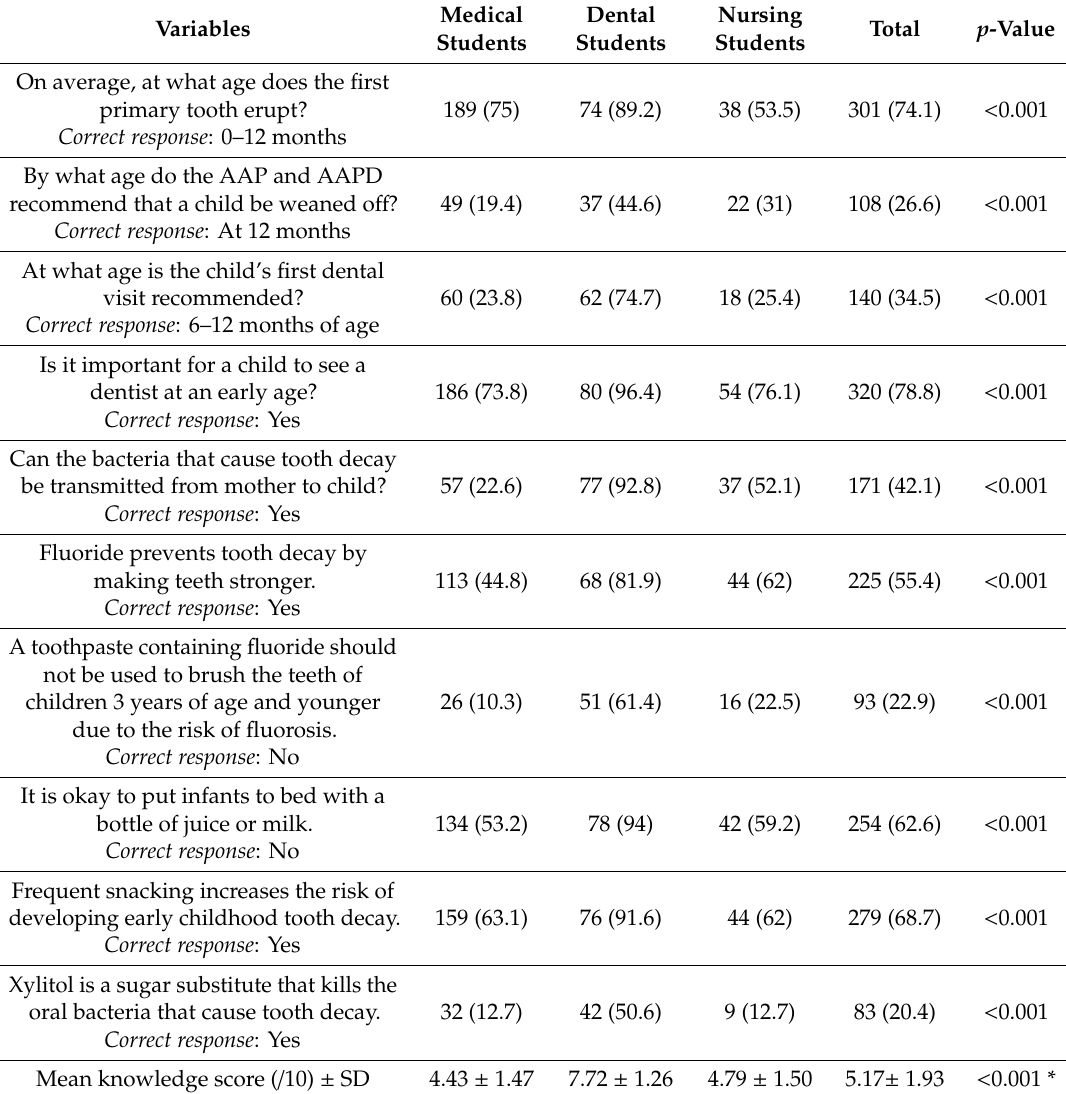
Table 2. Frequency (percentage) of correct answer in questions of part two of the